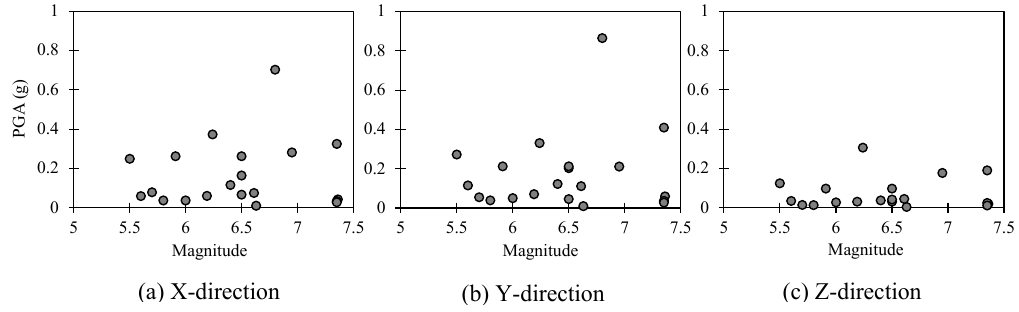
Figure 14. Magnitude versus peak ground acceleration (PGA) of selected ground motions.